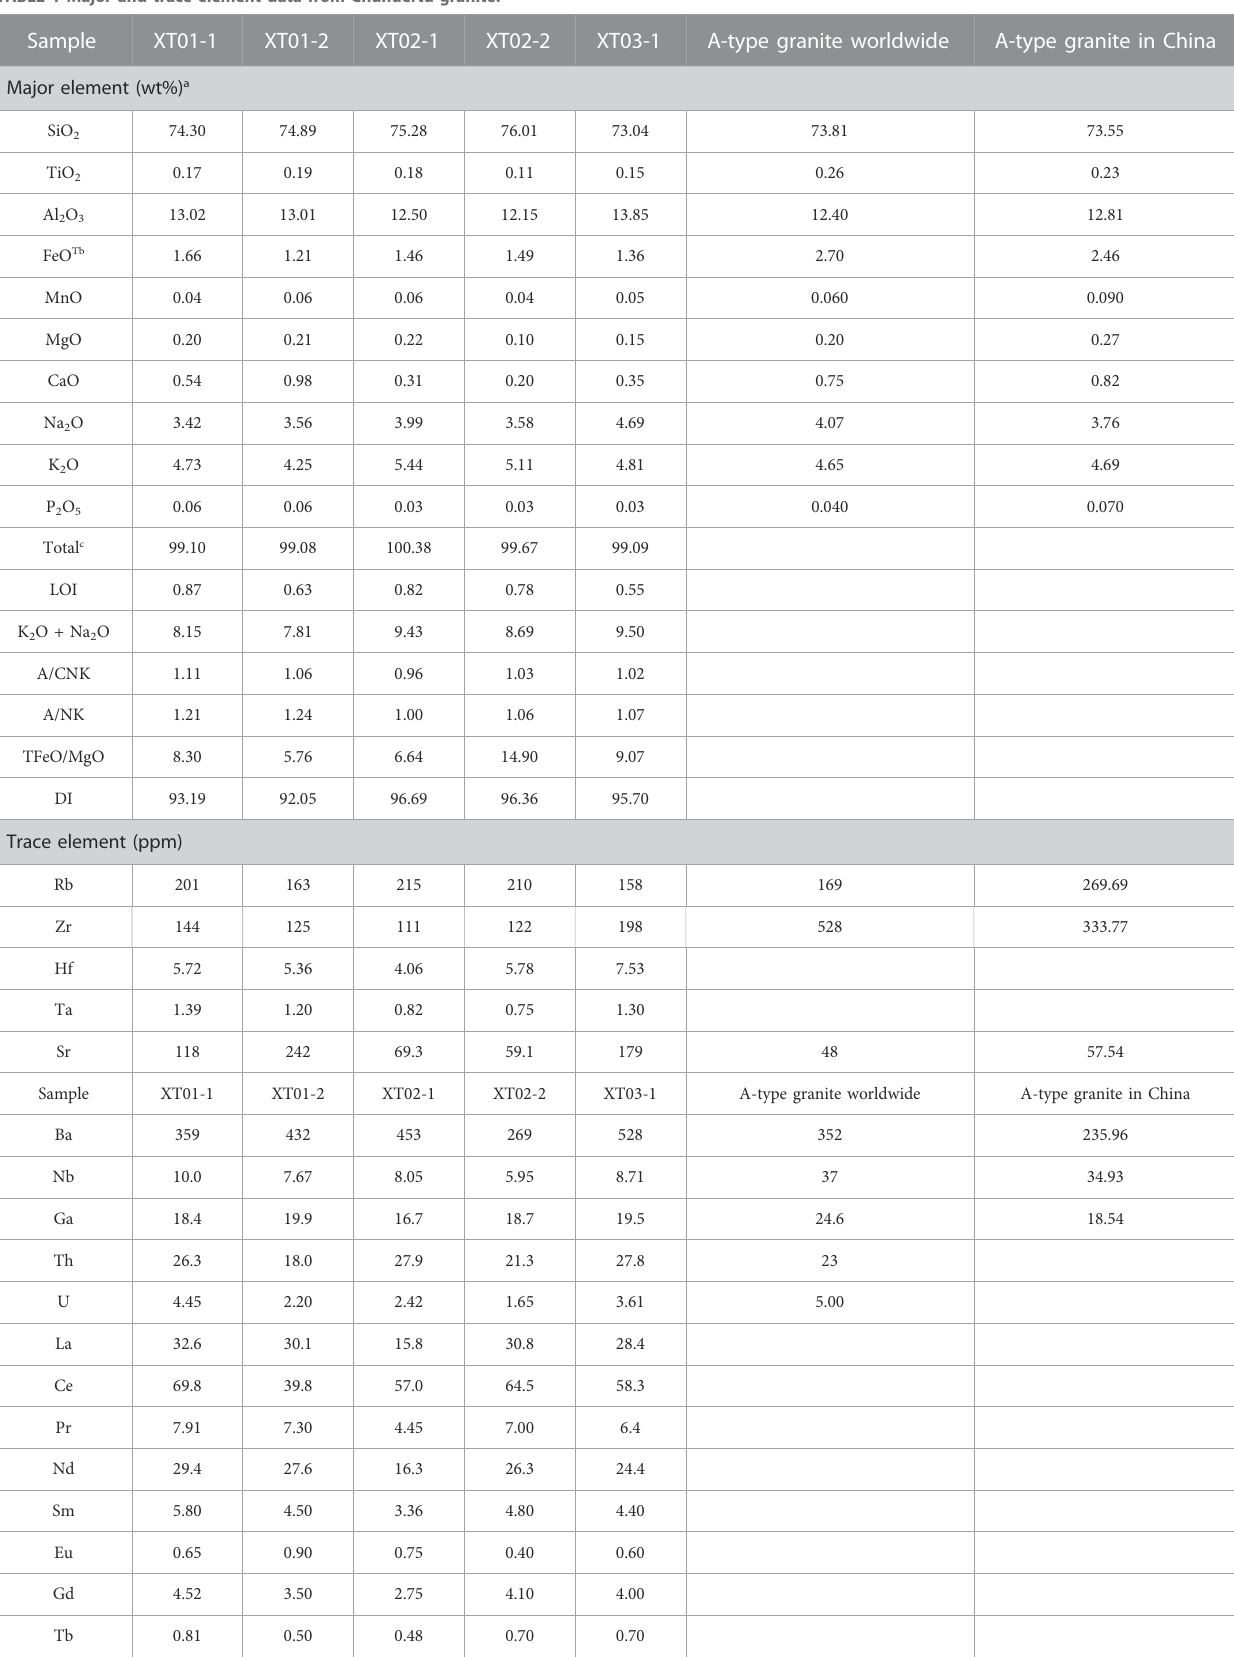
TABLE 1 Major and trace element data from Chuhuertu